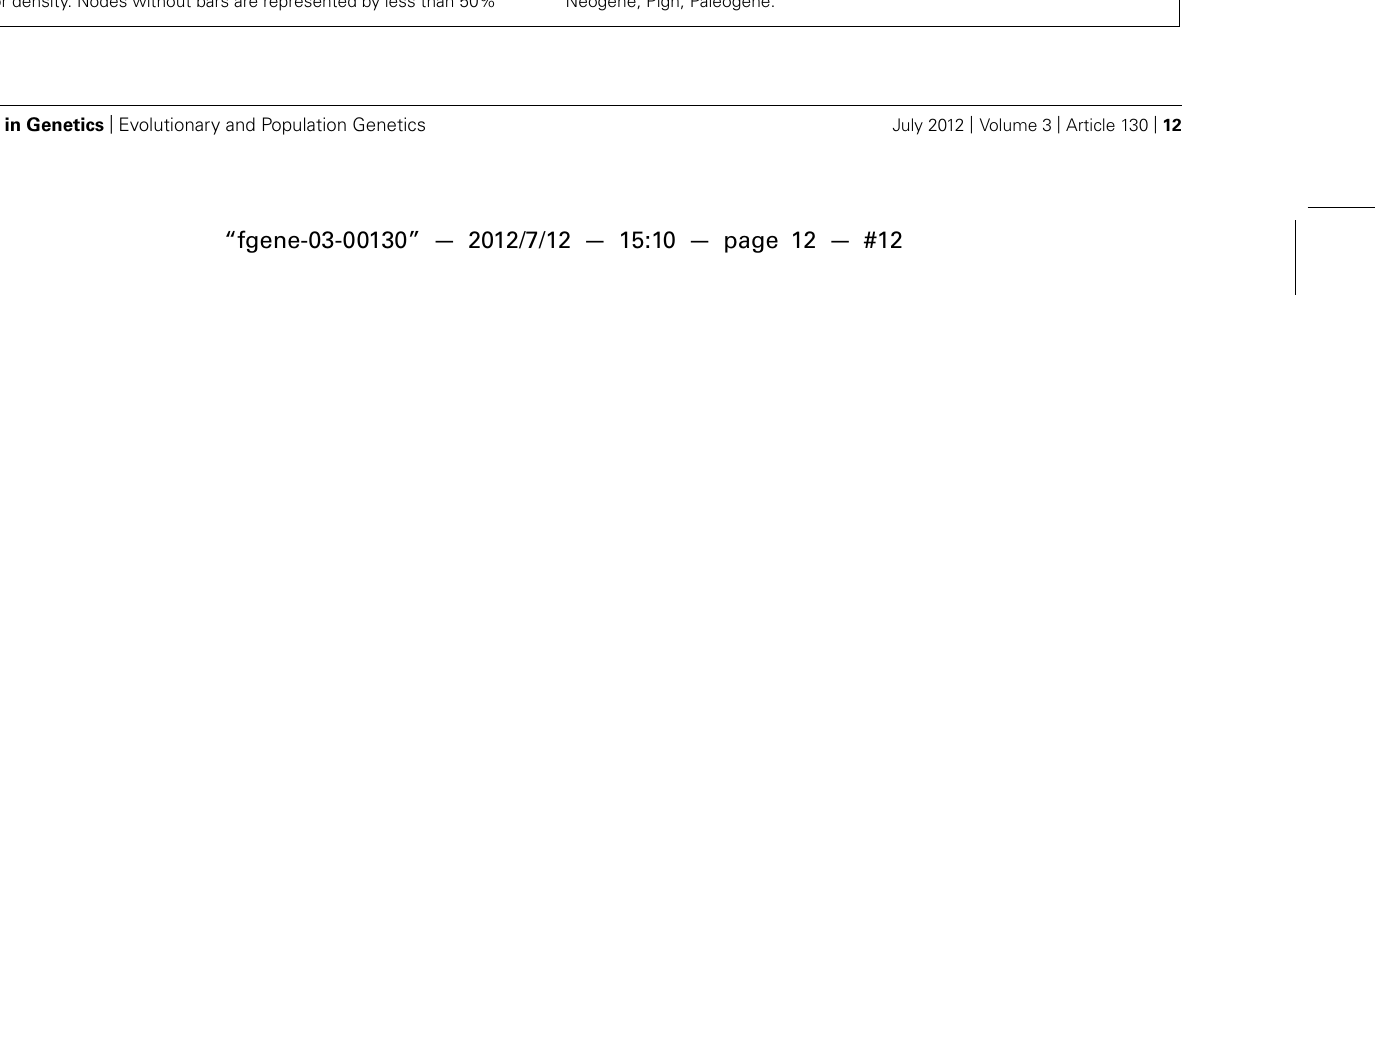
FIGURE 7 | Combined molecular and morphological timetree of limbed vertebrates. Modified from Pyron (2011). Gray bars represent 95% highest posterior density. Nodes without bars are represented by less than 50%